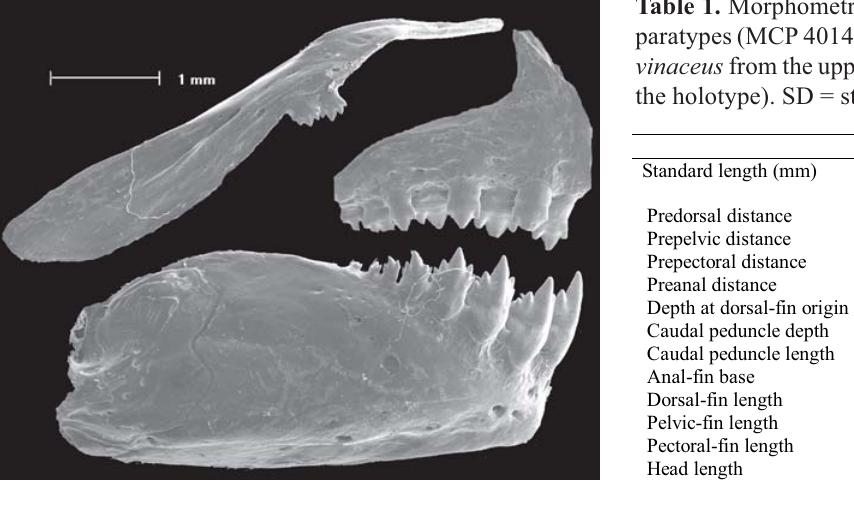
Fig. 2. Scanning electronic micrograph of upper and lower jaws (right side) of Hyphessobrycon vinaceus , MCP 40141, paratype, female, 49.6 mm